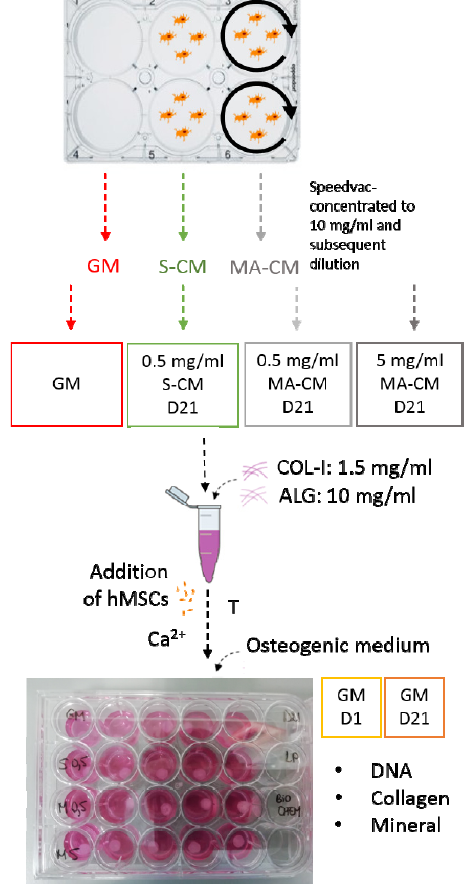
Figure 1. Experimental outline investigating the effect of osteocyte secreted factors on human mesenchymal stromal/stem cells (hMSC) osteogenesis within interpenetrating polymer network (IPN) hydrogels comprising collagen type I (COL-I) and alginate (ALG). Five different groups are investigated: GM = growth medium ( α -modification of Eagle’s minimal essential medium ( α -MEM) supplemented with 10% fetal bovine serum (FBS), 1% Pen/Strep, and 1% L-glutamine), 0.5 mg/mL statically cultured osteocyte conditioned media (S-CM) supplemented with 10% FBS, 0.5 mg/mL mechanically activated osteocyte conditioned media (MA-CM), and 5 mg/mL MA-CM supplemented with 10% FBS. hMSCs were resuspended into these media groups and incorporated into the COL-I/ALG hydrogel subsequently exposed to thermal gelation (T), ionic crosslinking (Ca 2+ ), and cultured for 21 days in osteogenic medium. DNA content, collagen, and mineral deposition was quantified at D1 and D21, n = 5.